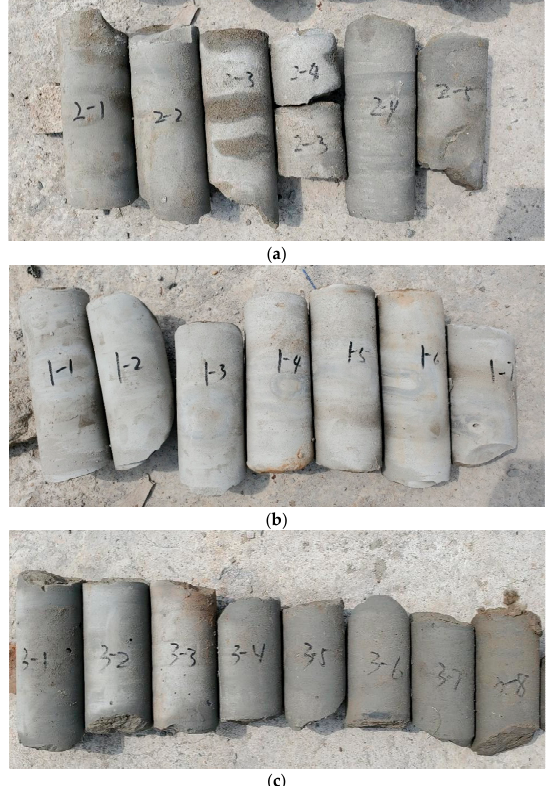
Figure 18. Core sampling of site tests. ( a ) HPCG. ( b ) RPCG. ( c ) MKCG.